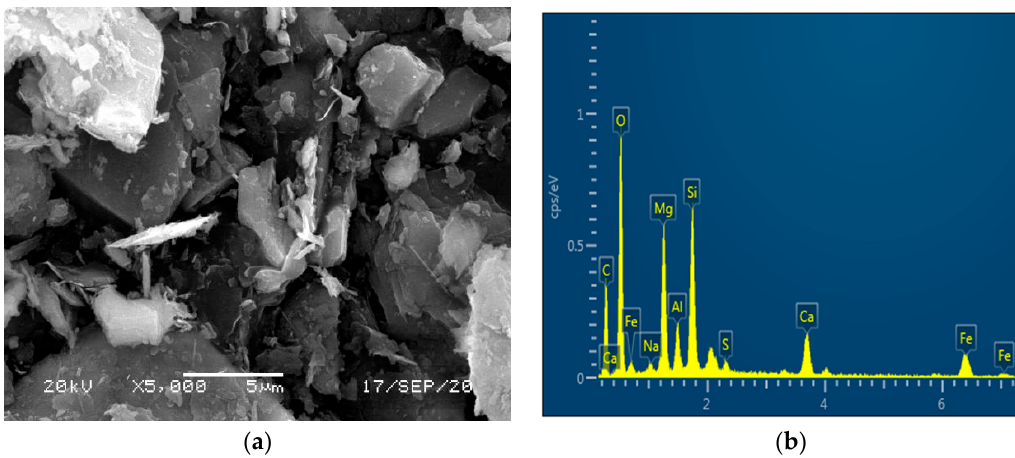
Figure 1. ( a ) SEM, ( b ) EDS. Microscopic characteristics of coastal soft soil.